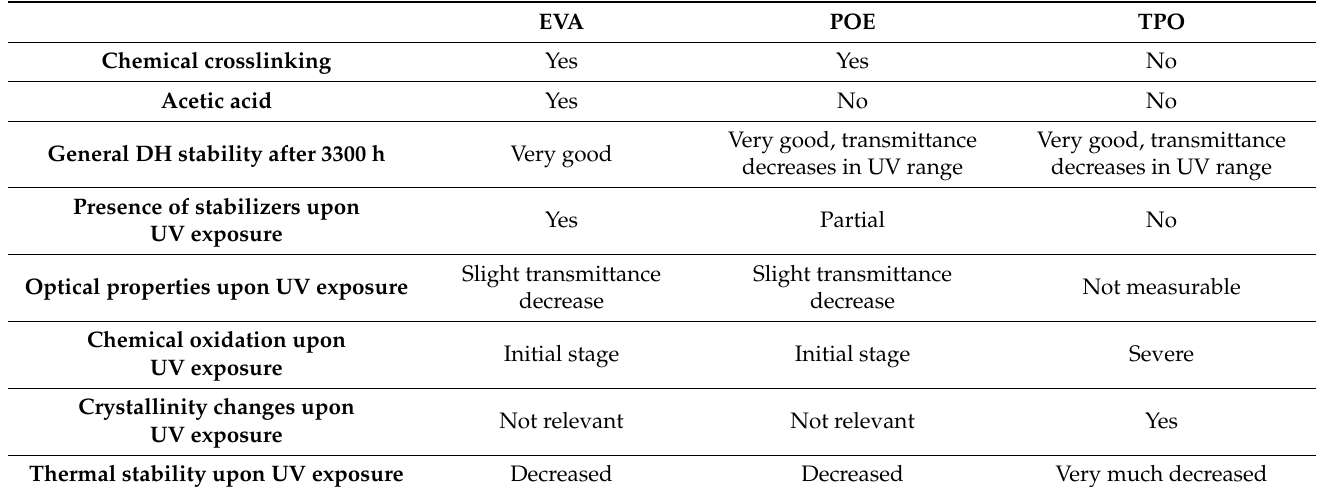
Table 6. Summary of encapsulants characteristics and performances observed in this study. EVA POE